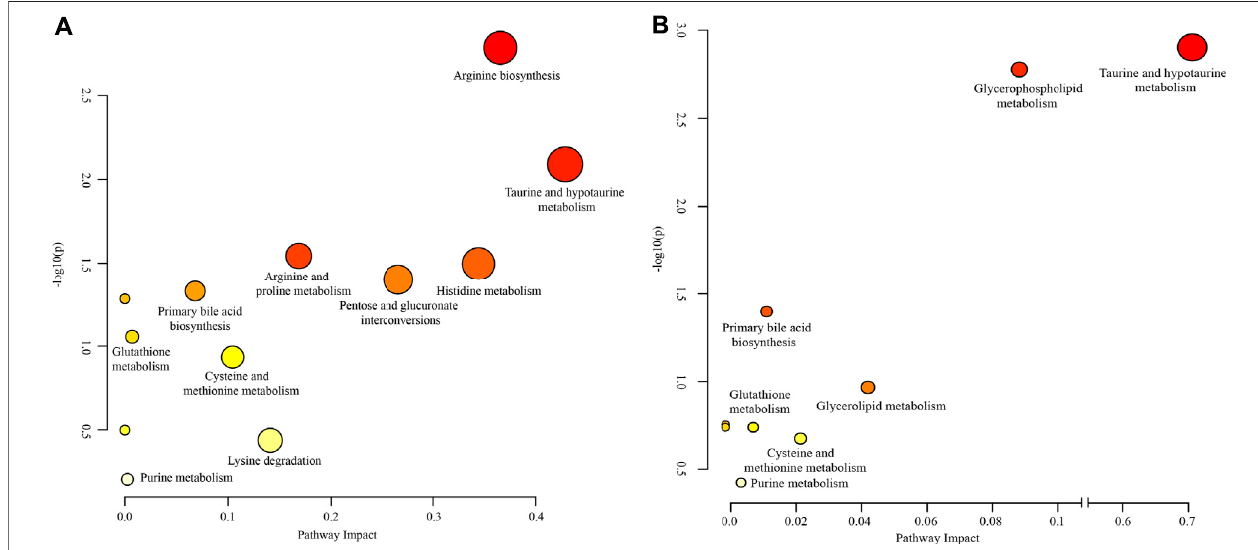
FIGURE 6 | Weighted analysis of the metabolic pathways based on the potential biomarkers in (A) serum and (B) kidney samples.